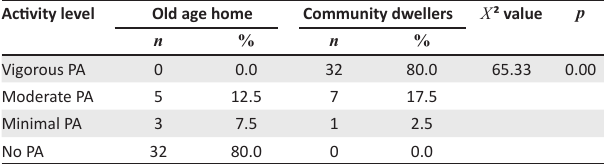
TABLE 4: The comparison of activity level of old age home vs. community